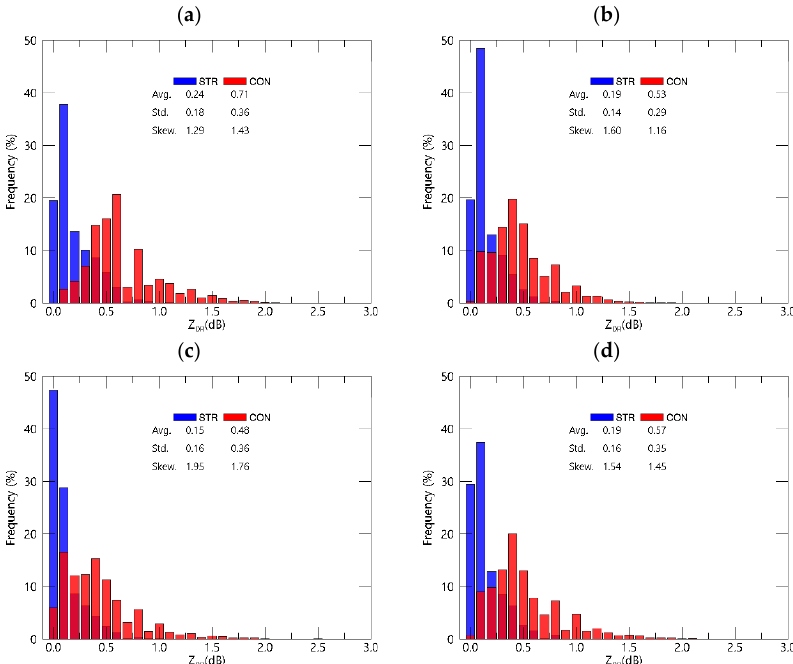
Figure 13. The occurrence frequency of differential reflectivity with rain types at ( a ) BOS, ( b ) BUS, ( c ) CPO, and ( d ) JIN site. The blue represents stratiform rain and the red represents convective rain. The legend shows the average (Avg.), standard deviation (Std.), and skewness (Skew) of differential reflectivity for both rain types. Figure 14 shows the occurrence frequency of specific differential phase with rain types at each site. The frequency of stratiform rain was 100% below 0.1 dB at the four studied sites. The average specific differential phase of stratiform rain for all sites were 0.1 deg km − 1 . The average specific differential phase of convective rain was 0.25 deg km − 1 at BOS, 0.19 deg km − 1 at BUS, 0.16 deg km − 1 at CPO, and 0.22 deg km − 1 at JIN. This would be one of research topic on separation of rain types using polarimetric radar observation.